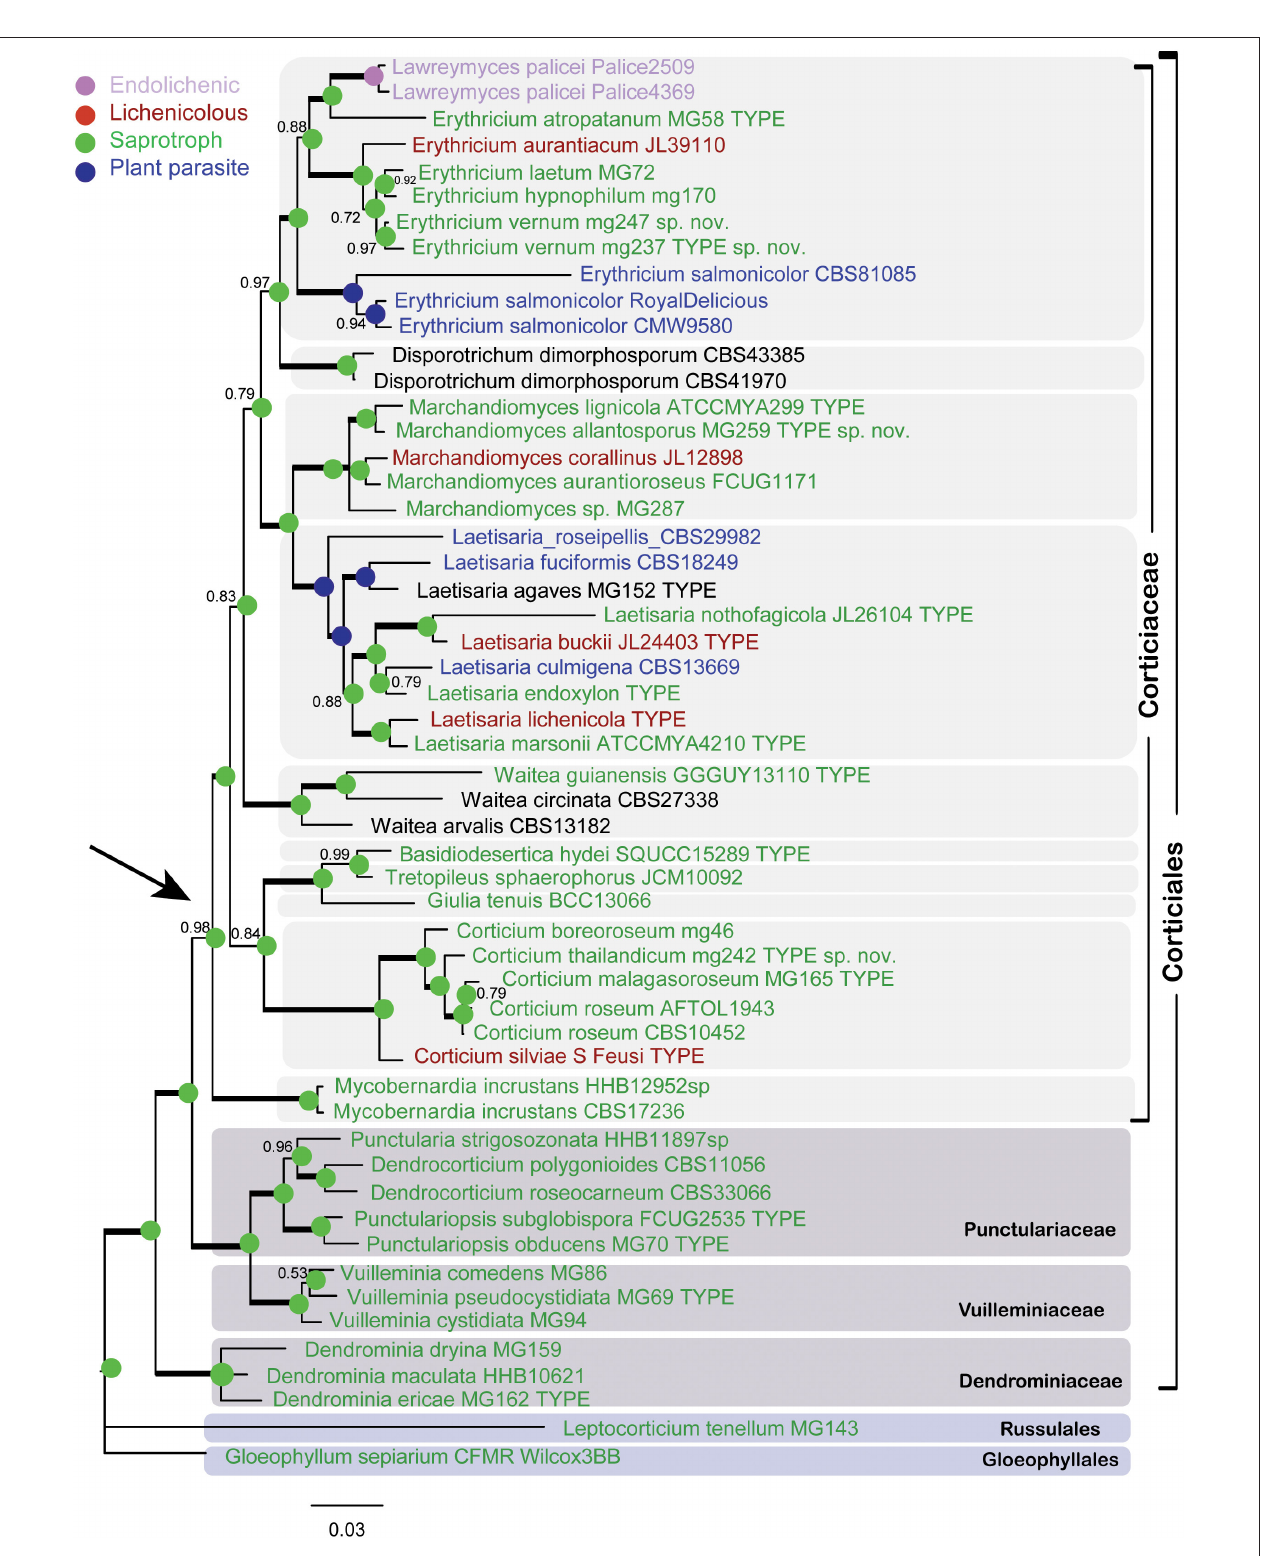
FIGURE 2 | Bayesian phylogram of the concatenated nLSU-ITS-SSU-mtSSU dataset for Corticiaceae. Clades for the Corticiaceae genera are marked with light gray boxes. Branches in bold have the posterior probability = 1.00. Taxa are colored according to their nutritional mode (taxa names in black have uncertain nutritional habit). The colored nodes show the ancestral character state inferred from parsimony analyses. The tree is rooted with Gloeophyllum sepiarium . The scale bar represents the expected changes per site.